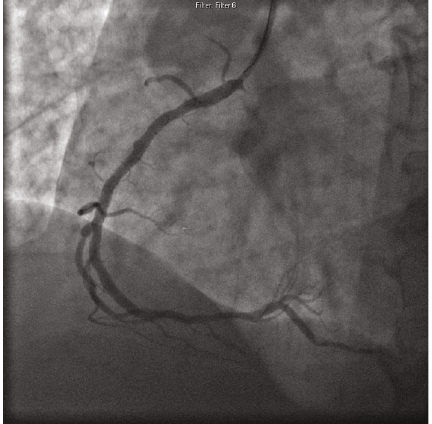
Figure 3: Right coronary artery after intravascular